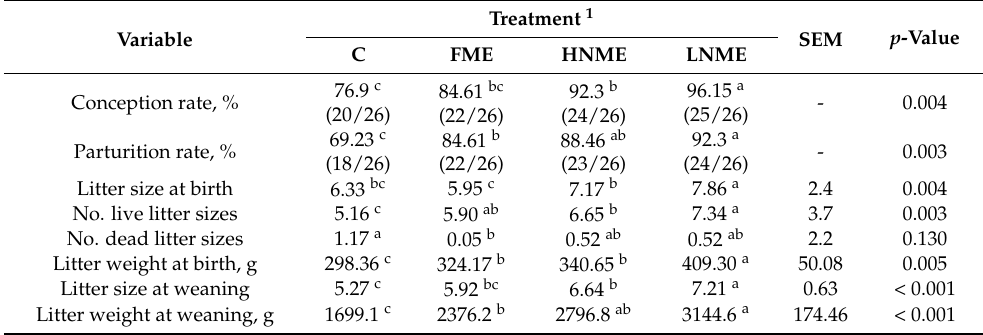
Table 5. Effects of free and nano-encapsulated Moringa oleifera leaf ethanolic extract (ME) supplemen- tations on the reproductive performance of multiparous rabbit does during the experimental period (mean ±